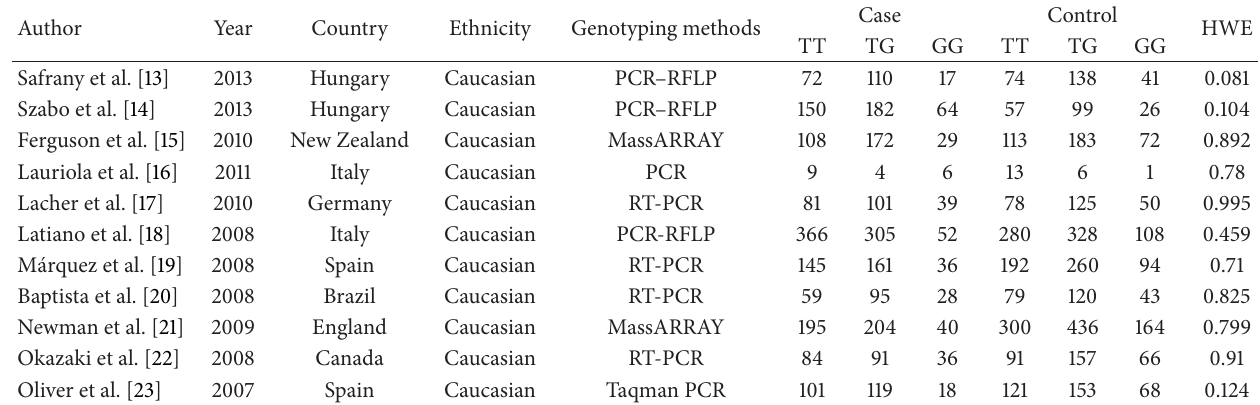
Table 1: Characteristics of eligible studies included in the meta-analysis.